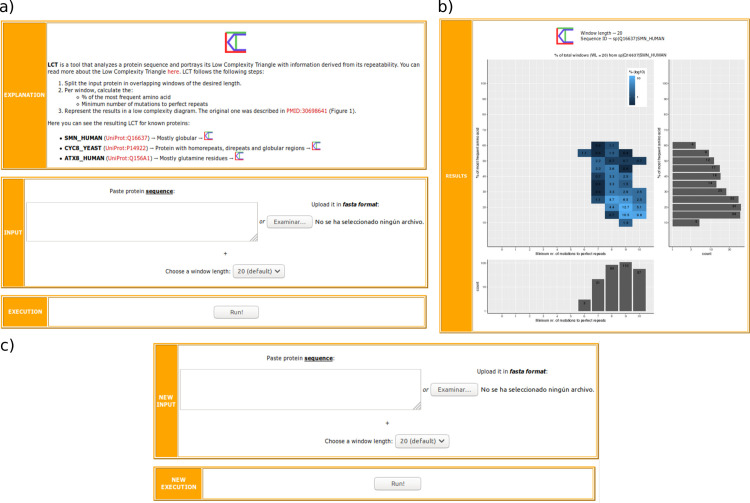
LCT web tool.a) Home page, b) results page, and c) iteration section in the